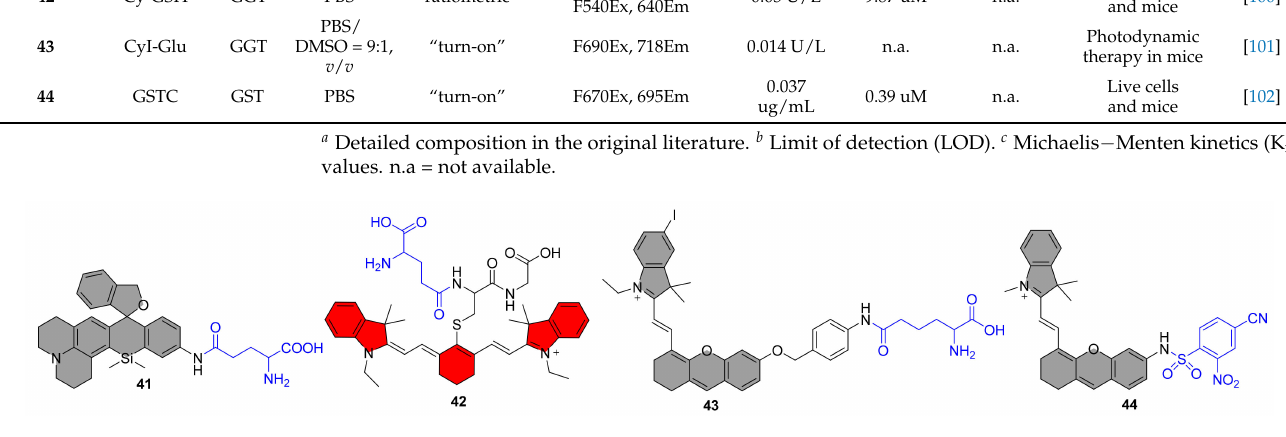
Figure 5. Structures of NIR Fluorescent Probes 41 – 44